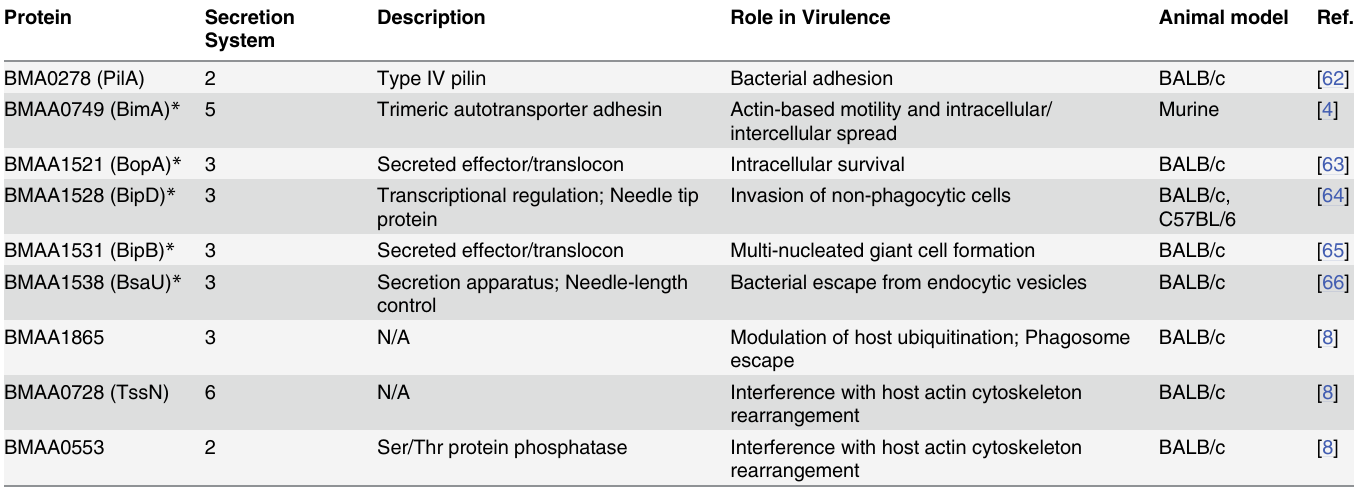
Table 1. Known B . mallei virulence factors that have been shown to attenuate the disease in animal models.